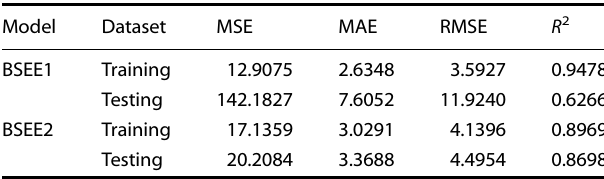
Table 4. Comparison of regression effects of two kinds of BSEE.